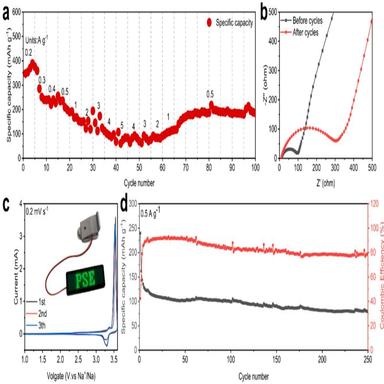
Electrochemical performance of NVP//DF-N/S-800℃ full cell. (a) Plot of full-cell multiplicity performance; (b) Plot of impedance before and after full-cell cycling; (c) CV curve at 0.2 mV s − 1 ; (d) Cycling performance at 0.5 A/g.